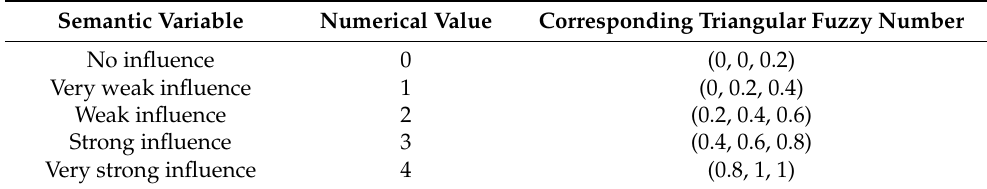
Table 2. Semantic transformation